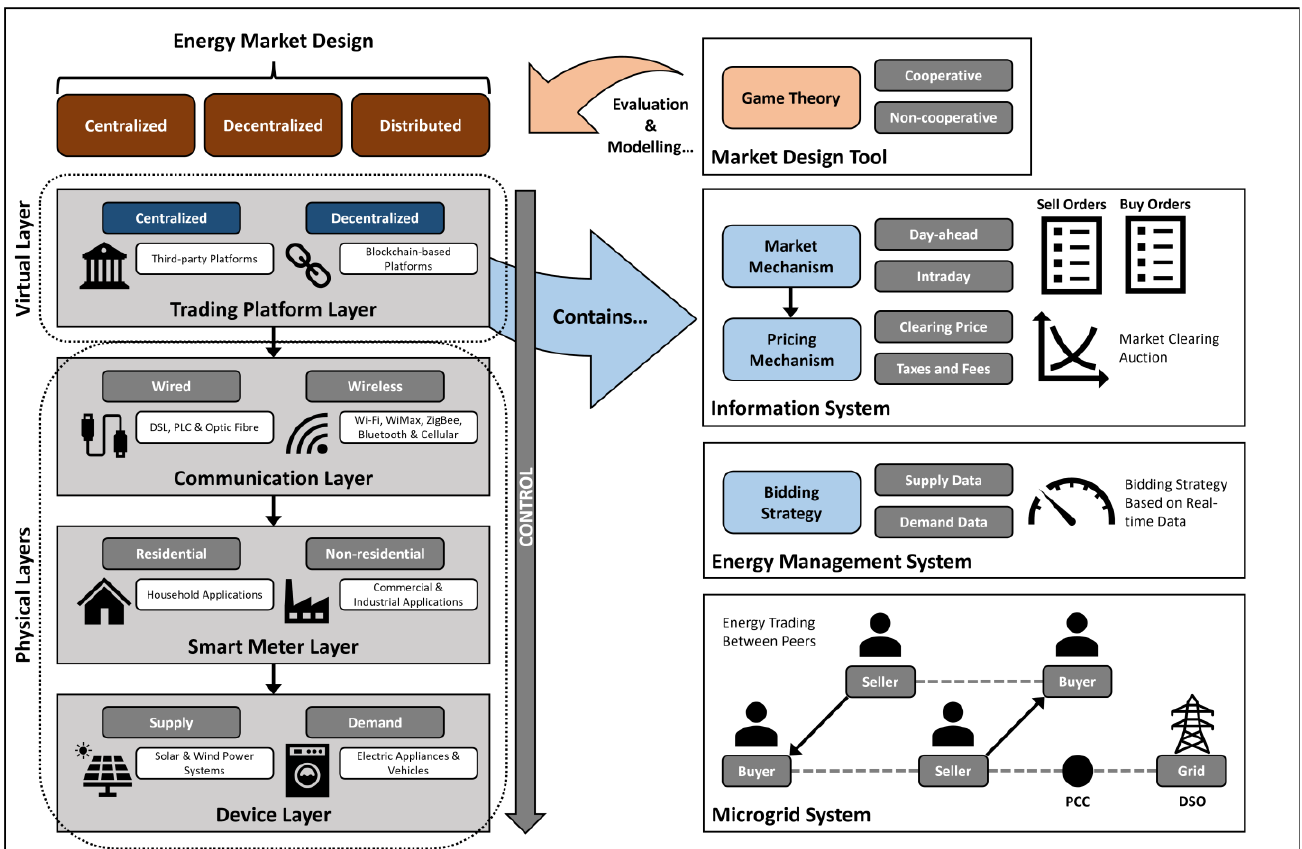
Figure 3. Diagram of the typical structure of LEMs for P2P energy trading in MGs and its distinct virtual and physical layers.